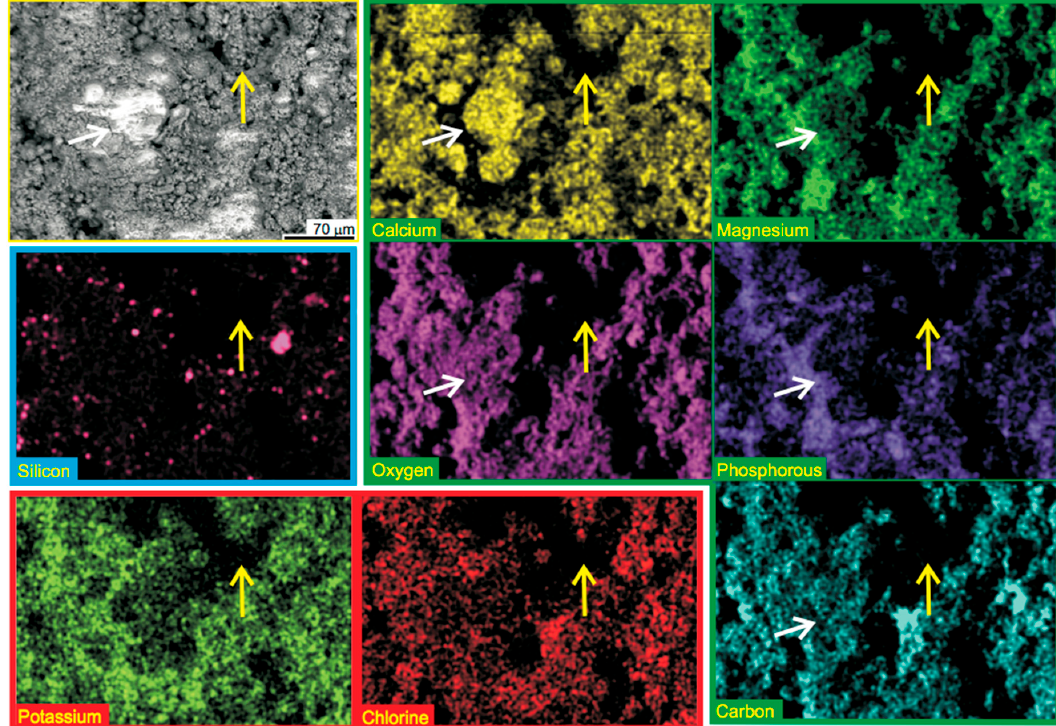
Figure 6. Energy-dispersive X-ray spectroscopy (EDS) maps of a cross-polished urinary stone of a guinea pig (magnified view of a porous region, see Figure 5 for an overview). The top left image is the corresponding scanning electron micrograph, and the yellow frame indicates the area selected for EDS mapping. White arrows highlight an exemplified feature in which calcium carbonate is abundant but magnesium and phosphorous is not. Yellow arrows mark a region where none of the investigated elements can be found to a significant extent. The EDS maps are grouped according to Figure 5; calcium, magnesium, oxygen, phosphorous, and carbon ( green frame ); potassium, and sodium ( red frame ); and silicon ( blue frame ).